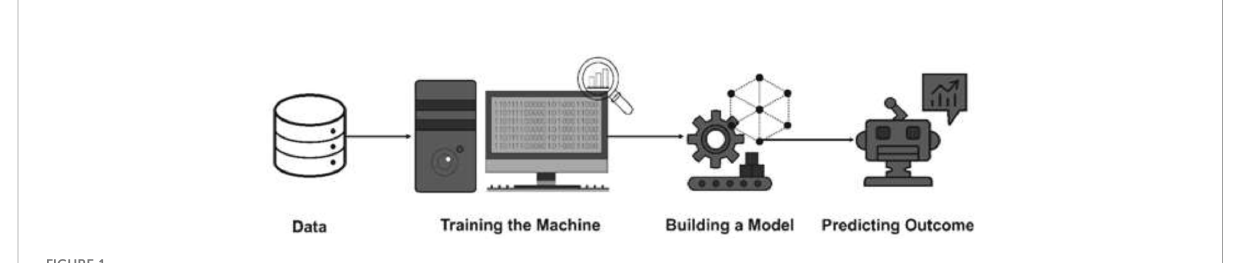
FIGURE 1 Architecture of Arti fi cial Intelligence (AI) system (reproduced from